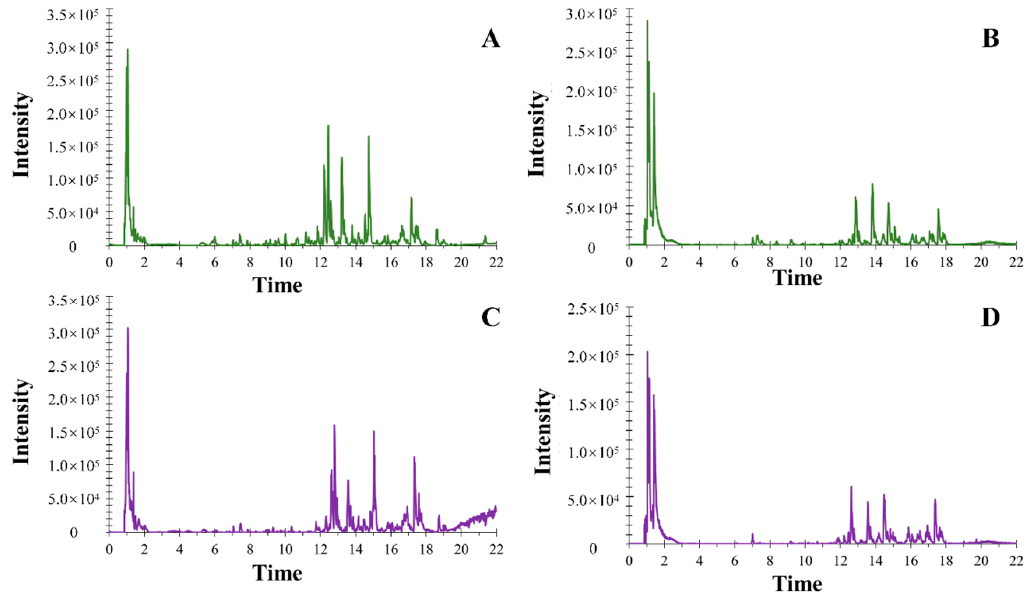
Figure 2. The base peak chromatograms (BPCs) in positive mode ( A : MG; B : MJ) and negative mode ( C : MG; D : MJ).